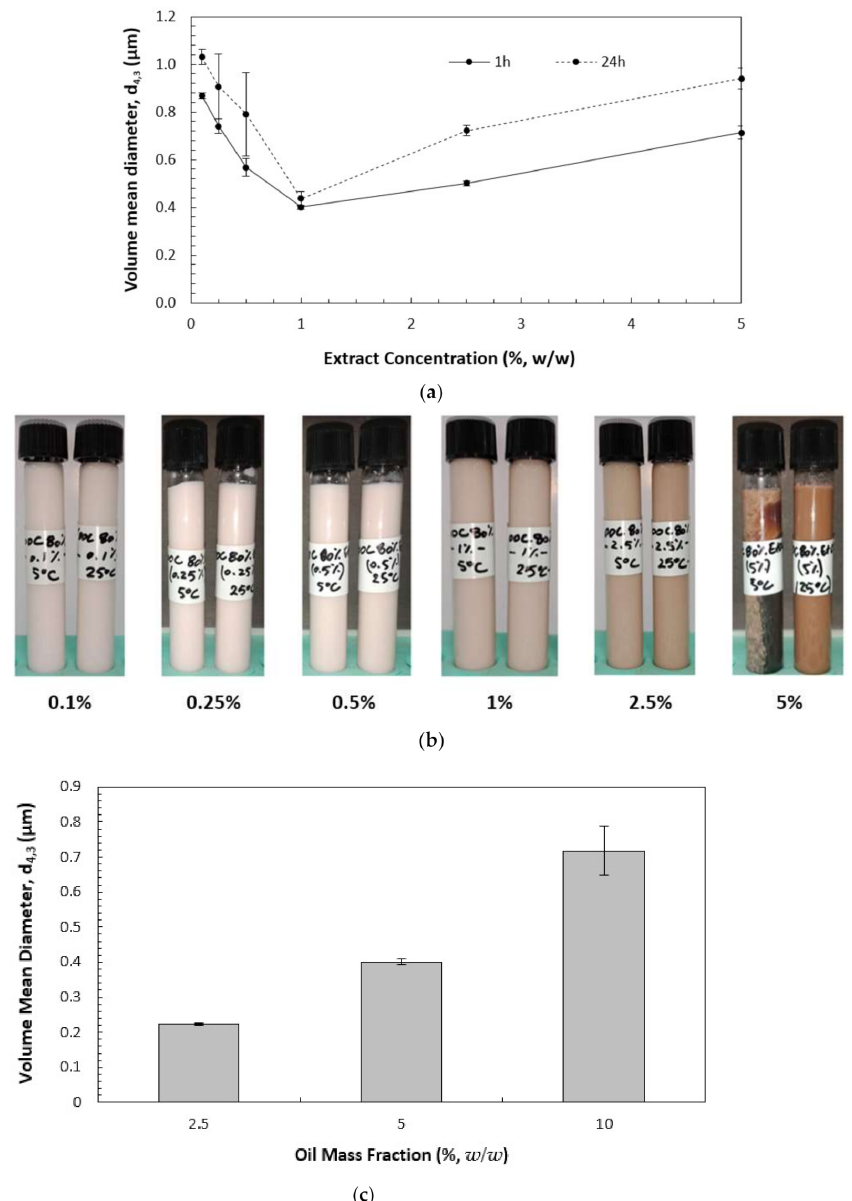
Figure 5. ( a ) Effect of OOC 80% ( w/w ) aqueous ethanolic extract concentration on the volume mean droplet diameter of emulsions after 1 and 24 h of storage at 5 ◦ C; ( b ) effect of OOC 80% extract concentration on the visual appearance of emulsions after 24 h of storage at 5 ◦ C. ( c ) Effect of oil mass fraction on the mean droplet size of emulsions after 24 h of storage at 5 ◦